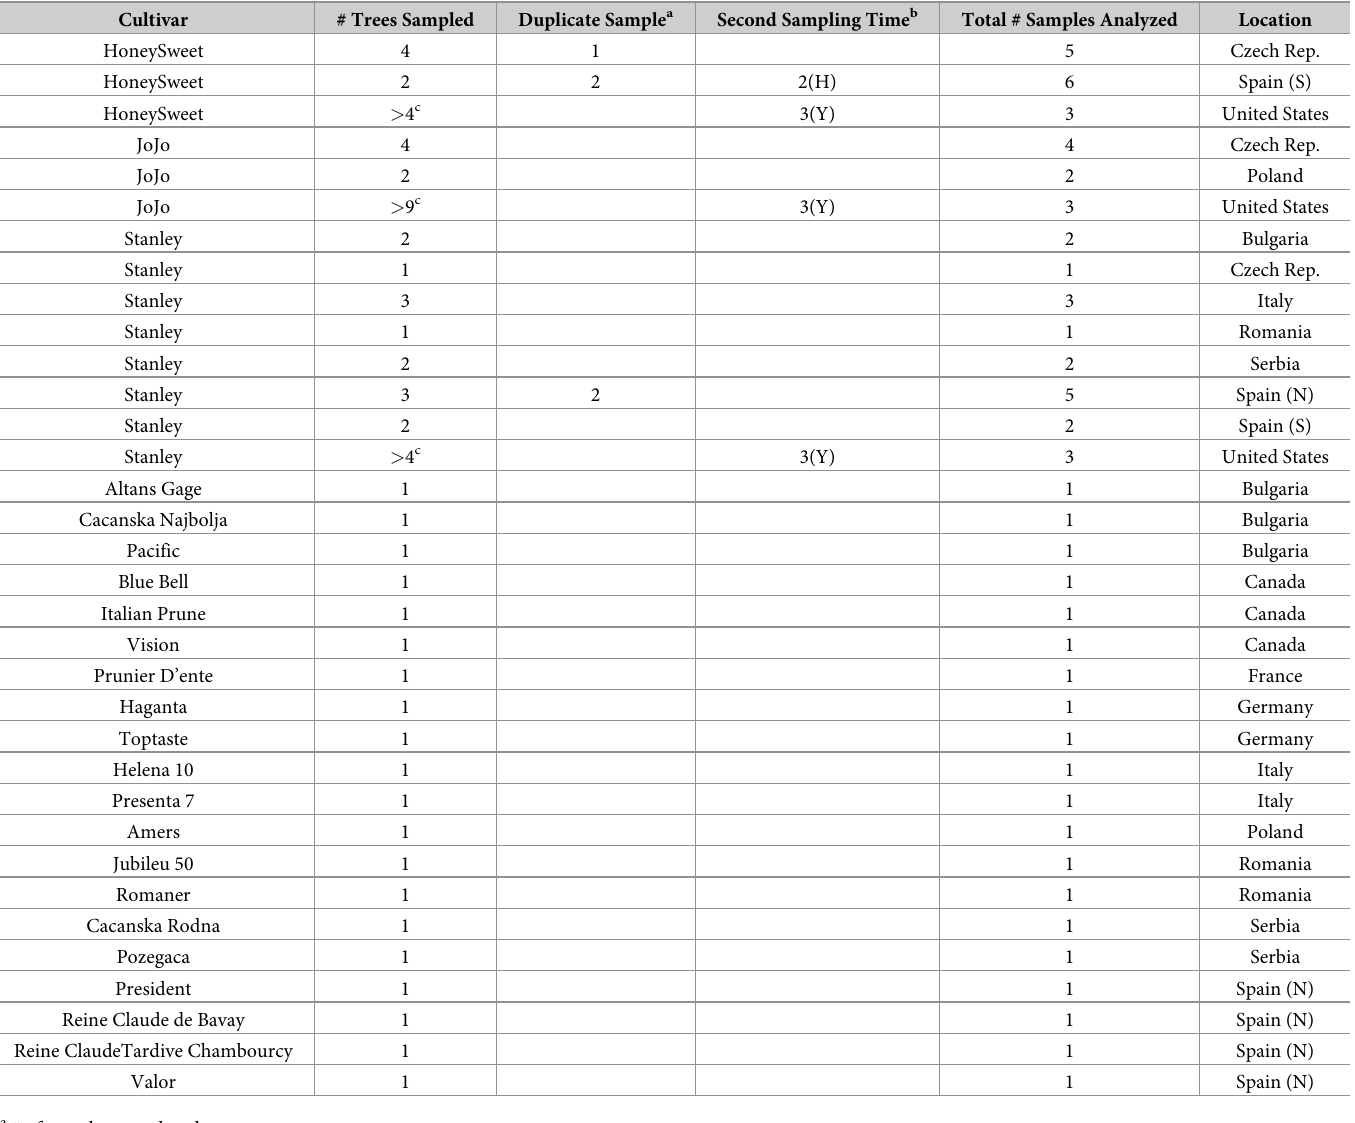
Table 1. Cultivars and locations analyzed for fruit